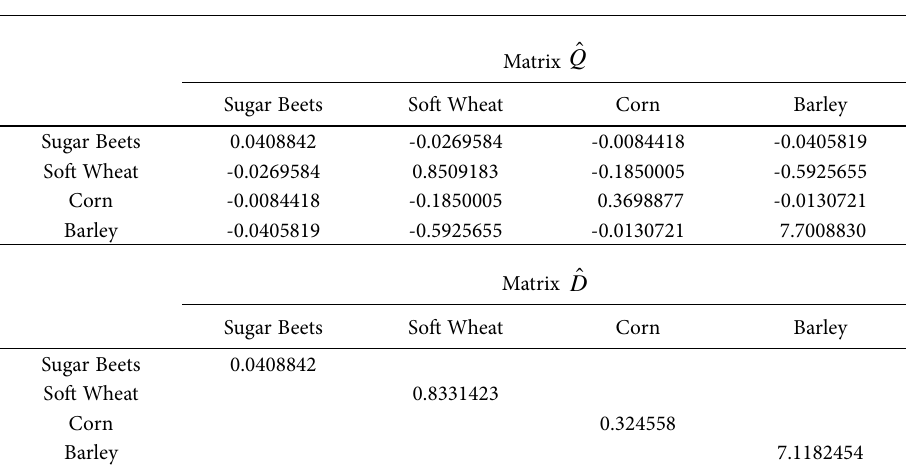
Table 9. Estimated matrices ˆ Q and ˆ D